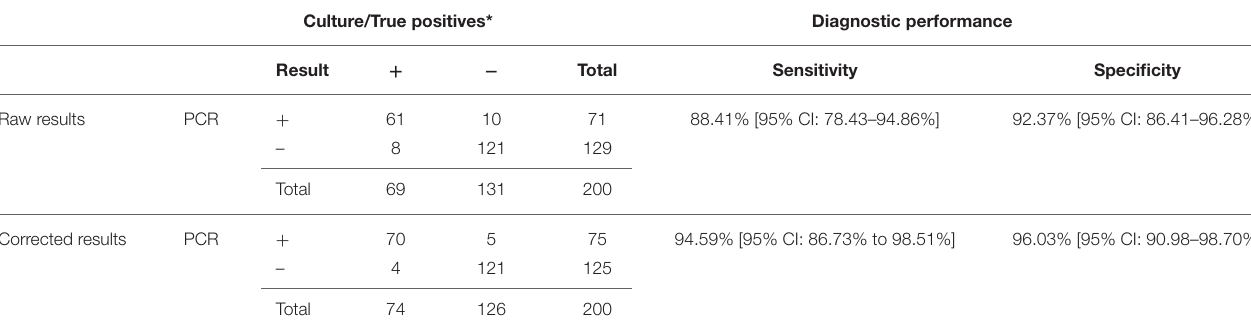
TABLE 1 | Comparison of results obtained by analyzing 200 randomly selected cattle samples by microbiological culture and Real-Time PCR.